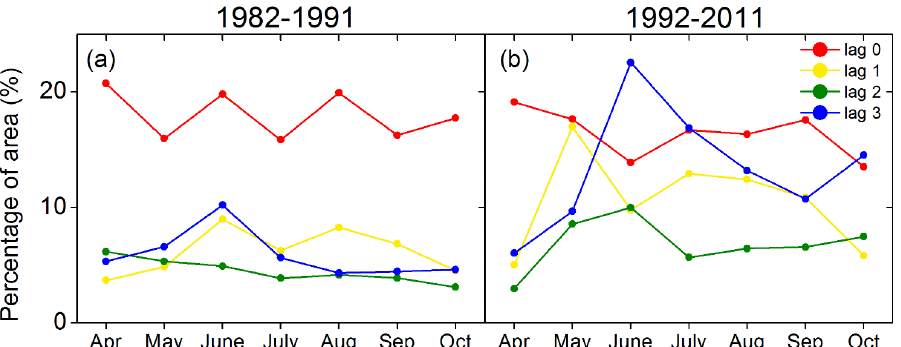
Figure 9. Percentage of vegetated area characterized by 0-month lag (red), 1-month lag (yellow), 2-month lag (green), and 3-month lag (blue) during ( a ) 1982–1991 and ( b ) 1992–2011 in NDVI response to precipitation ( p -value <